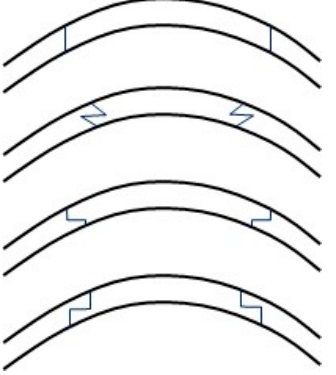
Figure 5. Variations in wound shapes for penetrating keratoplasty. From top to bottom; conventional, zigzag, mushroom, and top-hat morphology.